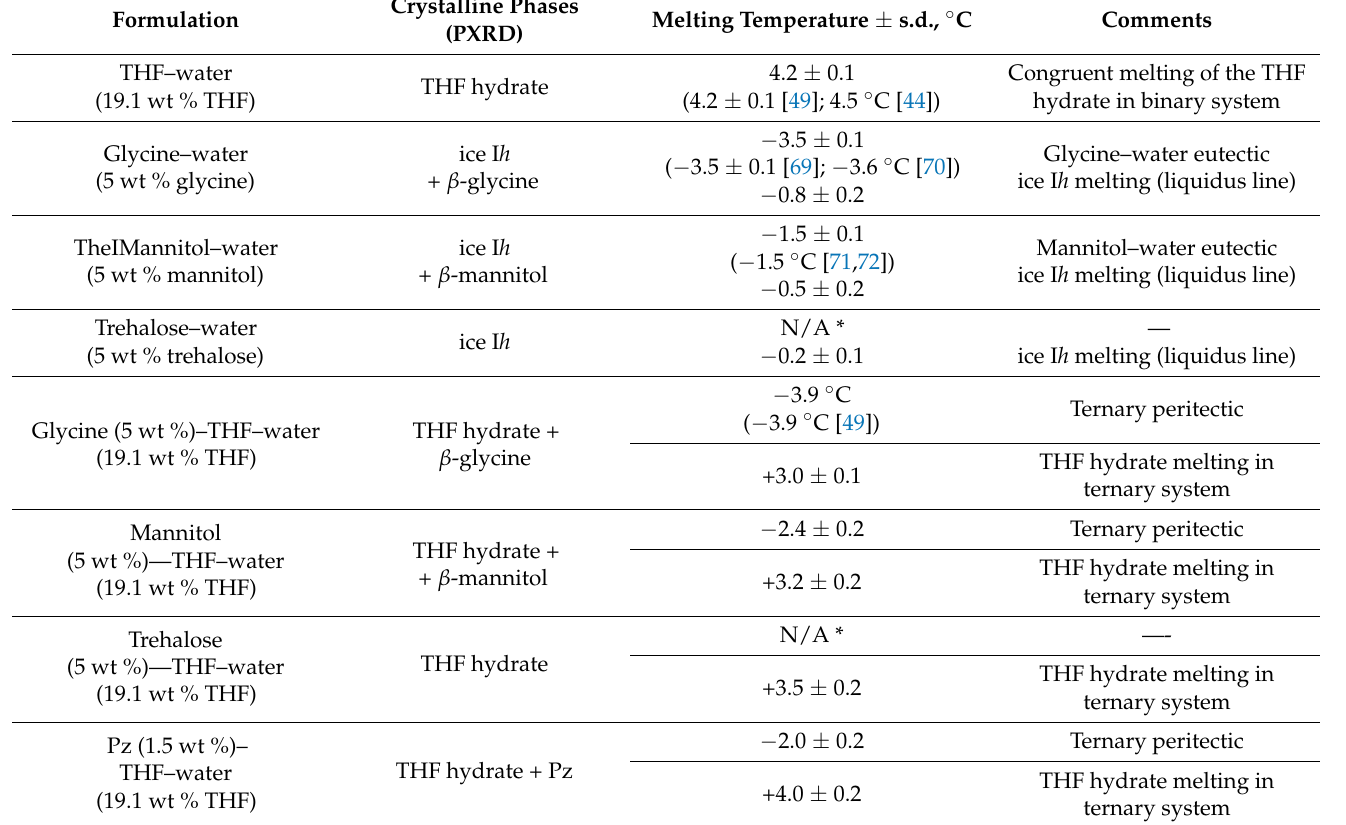
Table 1. Results of the thermal analysis experiments, aiming to study the melting behavior of the THF hydrate in ternary (solute (glycine–mannitol–trehalose–Pz)–THF–water) systems. Glycine, mannitol, and trehalose aqueous solutions were used as reference